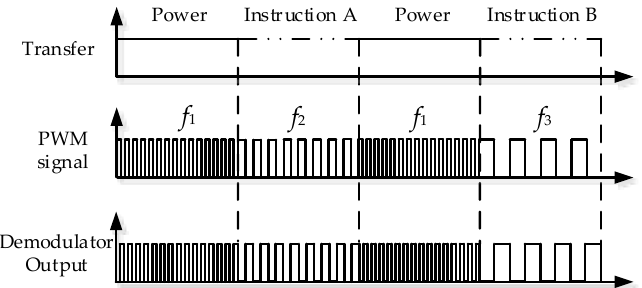
Figure 8. Modulation waveform of predefined instruction backward transmission.